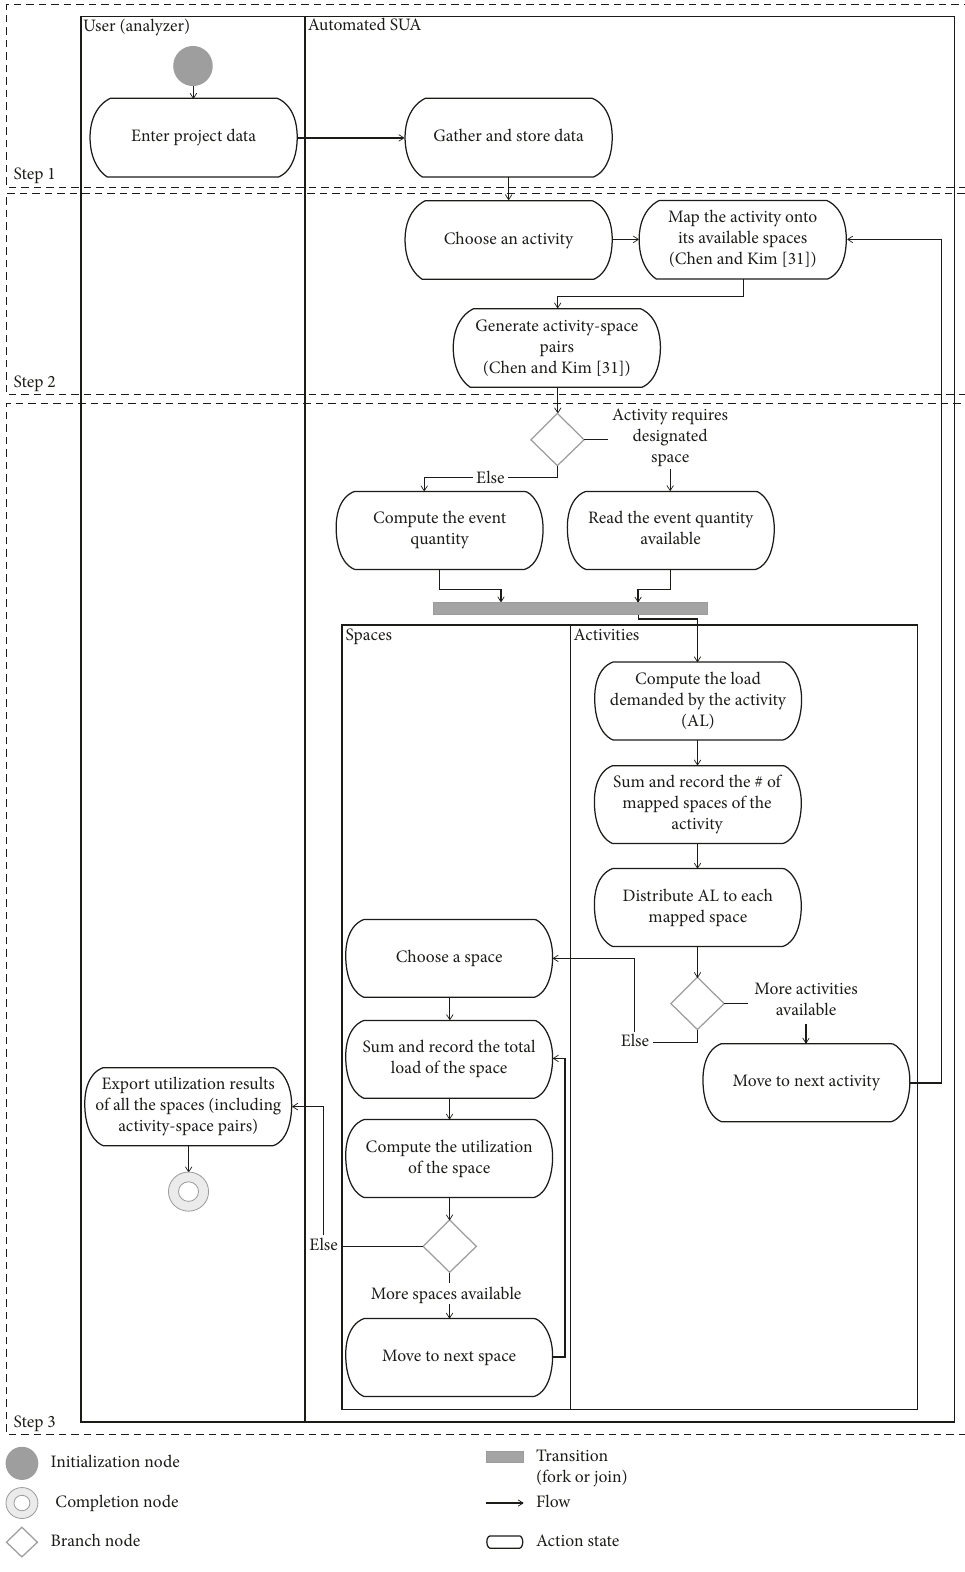
Figure 4: Implementation process for the automated